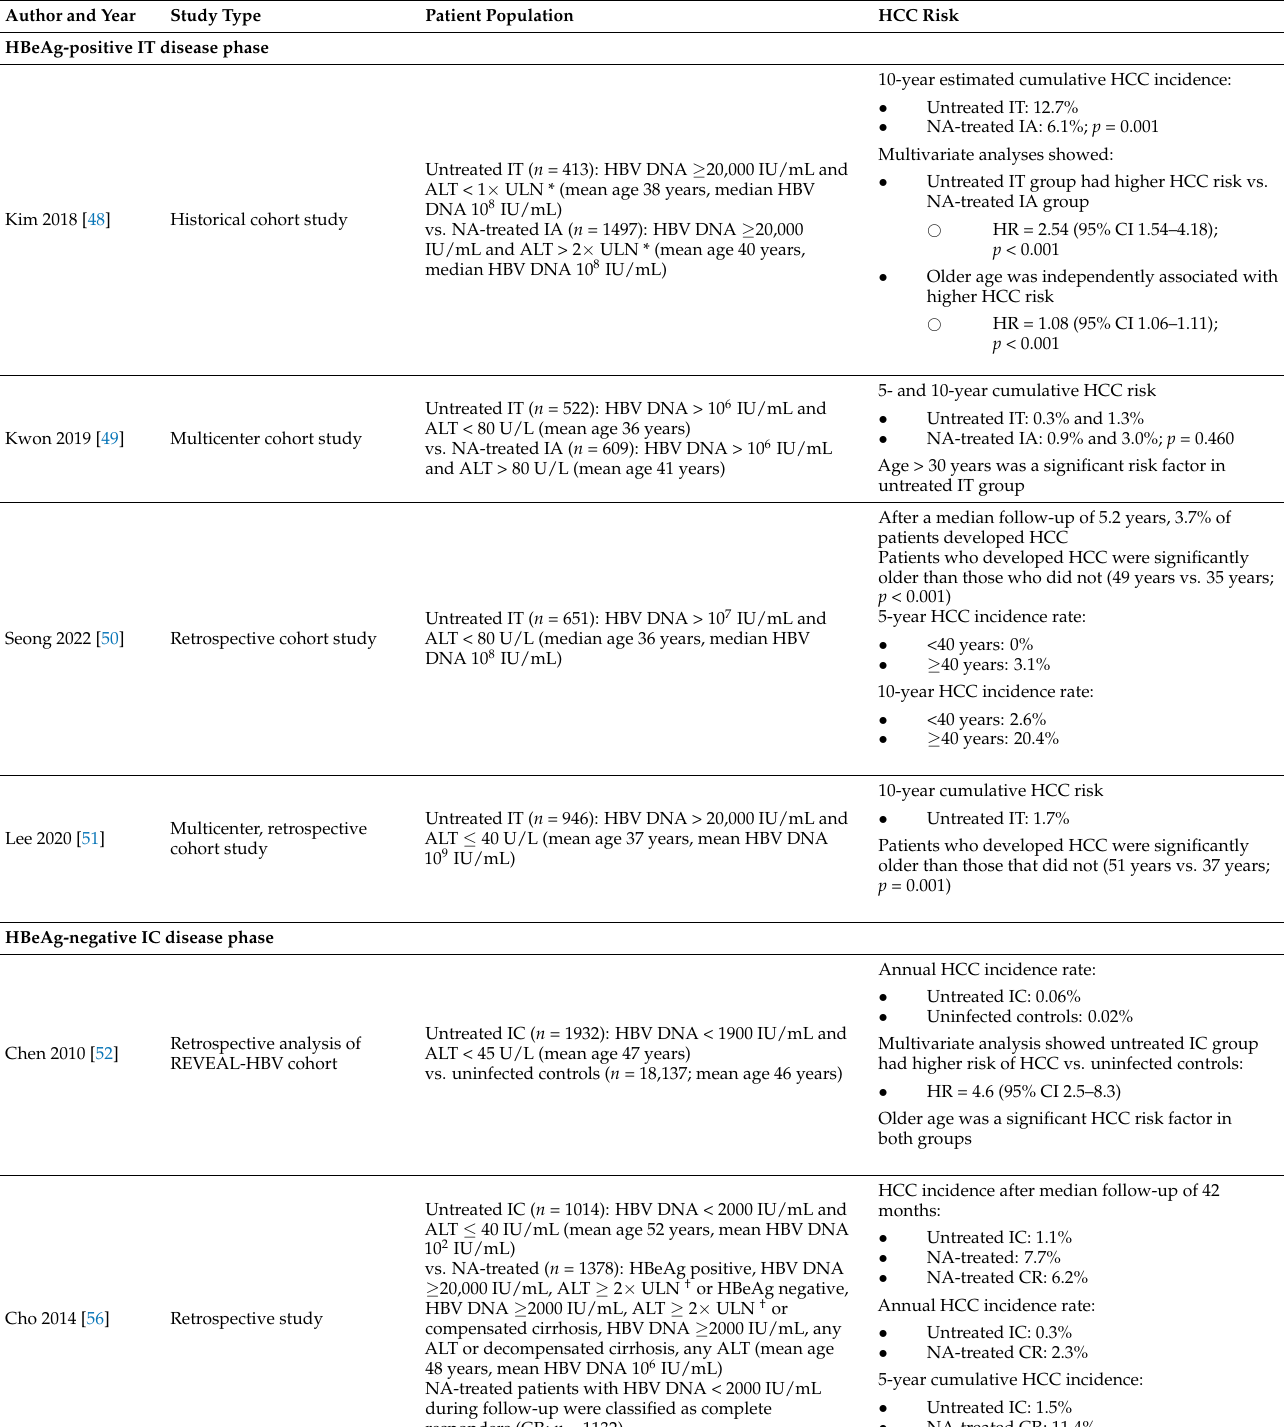
Table 2. HCC risk in CHB patients in HBeAg-positive IT, HBeAg-negative IC, and ‘gray zone’ disease